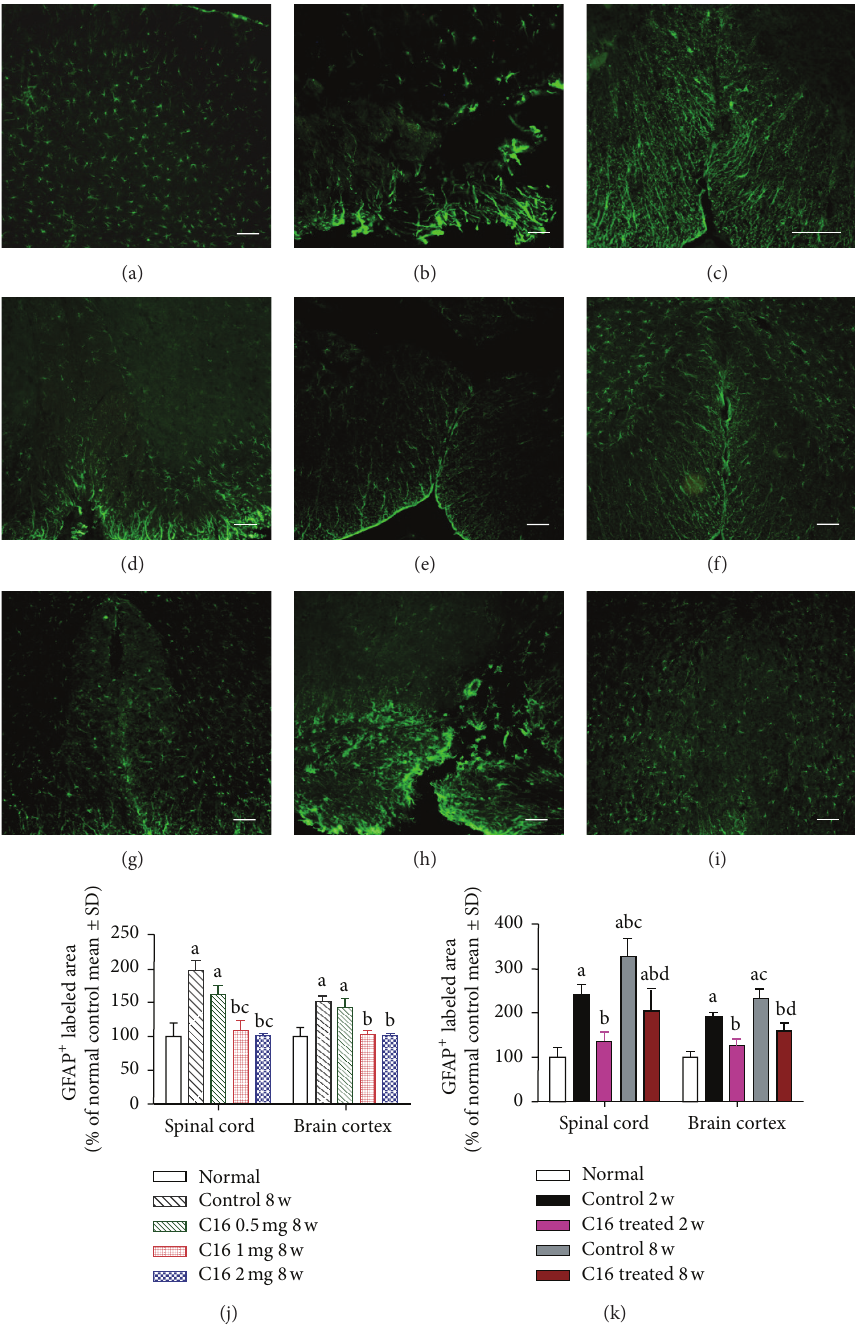
Figure 9: The C16 treatment inhibited reactive gliosis revealed by FITC-conjugated GFAP immunofluorescent staining; traverse section through the lumbar spinal cord; bar = 100 𝜇 m. At week 8 after immunization, normal rats group (a), vehicle control rats (b), 0.5 mg (c), 1mg/per day C16 treated EAE rats (d), and 2 mg/per day C16 treated EAE rats (e). Vehicle late treated EAE rats (f) and C16 late treated EAE rats (g) at week 2 after immunization. Vehicle late treated EAE rats (h) and C16 late treated EAE rats (i) at week 8 post-immunization. Medium and high dose C16 treatment reduced reactive gliosis (j). a 𝑃 < 0.05 versus normal rats, b 𝑃 < 0.05 versus vehicle control rats, and c 𝑃 < 0.05 versus 0.5 mg/per day C16 treated EAE rats at week 8 after immunization. (k) Late treated C16 treatment also inhibited reactive gliosis to a certain extent. a 𝑃 < 0.05 versus normal rats; b 𝑃 < 0.05 versus vehicle control rats; c 𝑃 < 0.05 versus C16 treated EAE rats at week 2 postimmunization group; d 𝑃 < 0.05 versus vehicle control rats at week 8 after